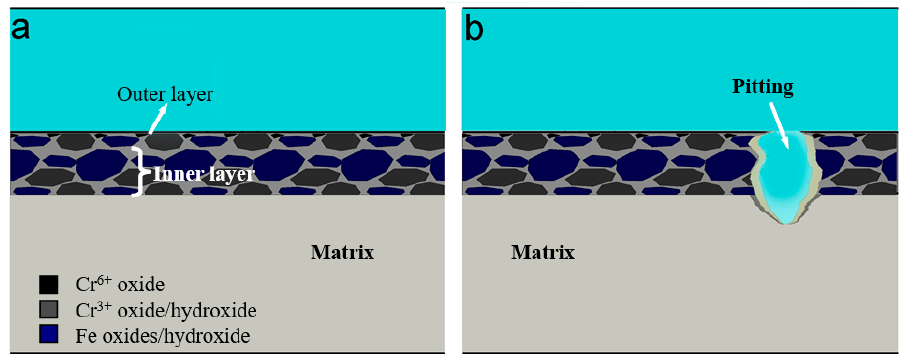
Figure 11. Sketch of the passivation film. ( a ) Passivation film formation stage, ( b ) Pitting stage.